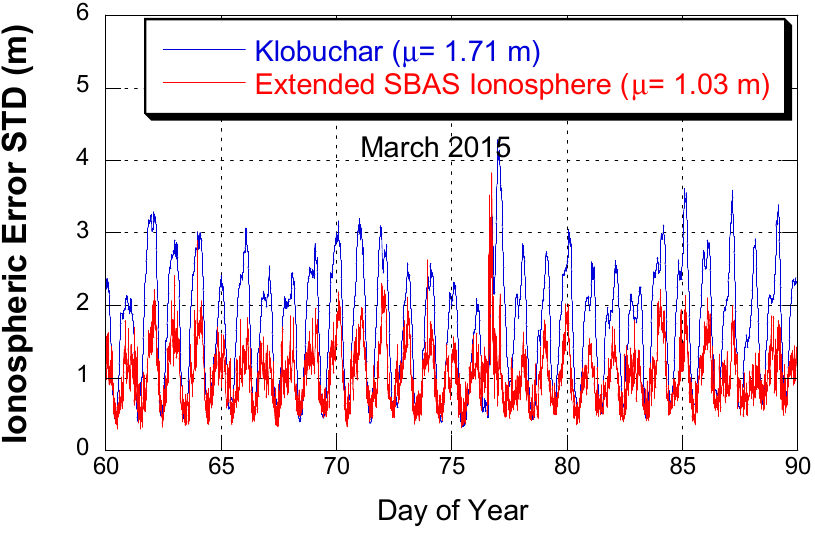
Figure 7. Time series of daily ionosphere error STD of the extended WAAS and Klobuchar models in March 2015.